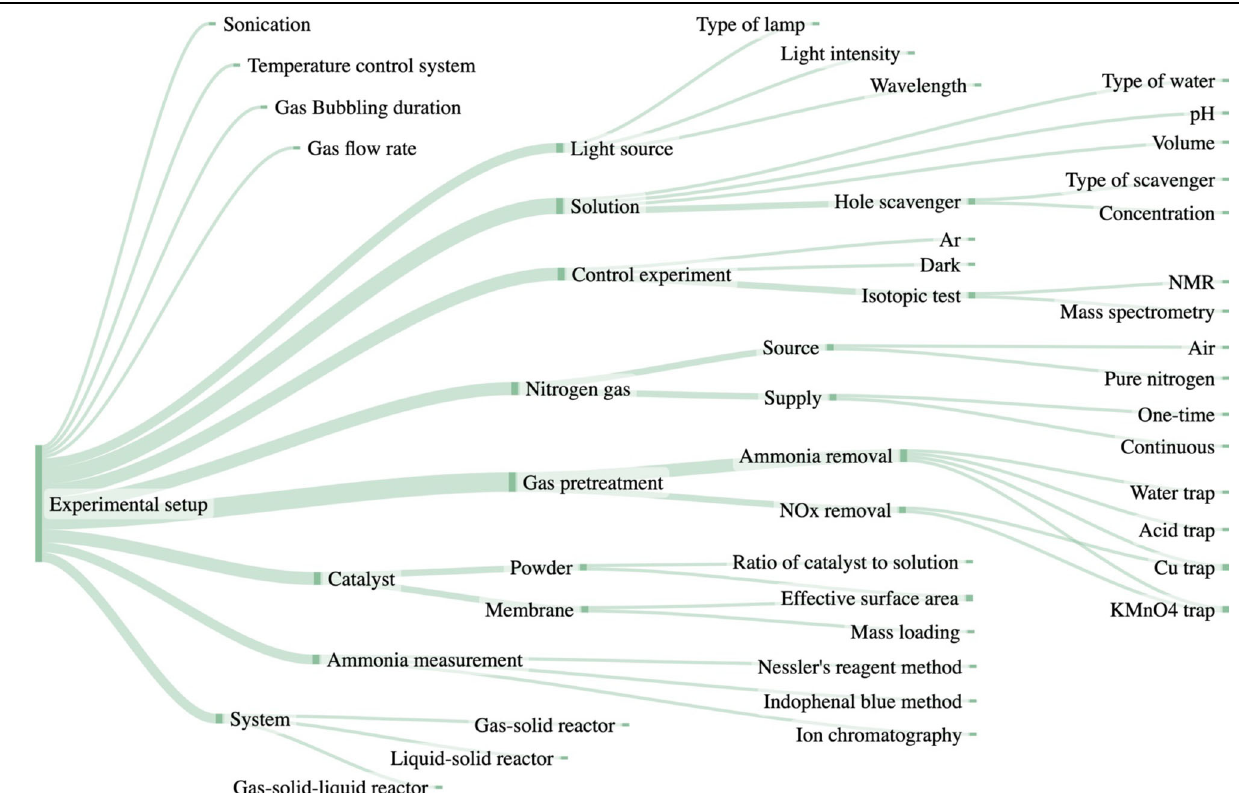
Fig. 3 | Unstandardized experimental parameters for photocatalytic NRR. Here we detail the parameters that may affect the photocatalytic ammonia yield. These parameters vary in different photocatalytic NRR